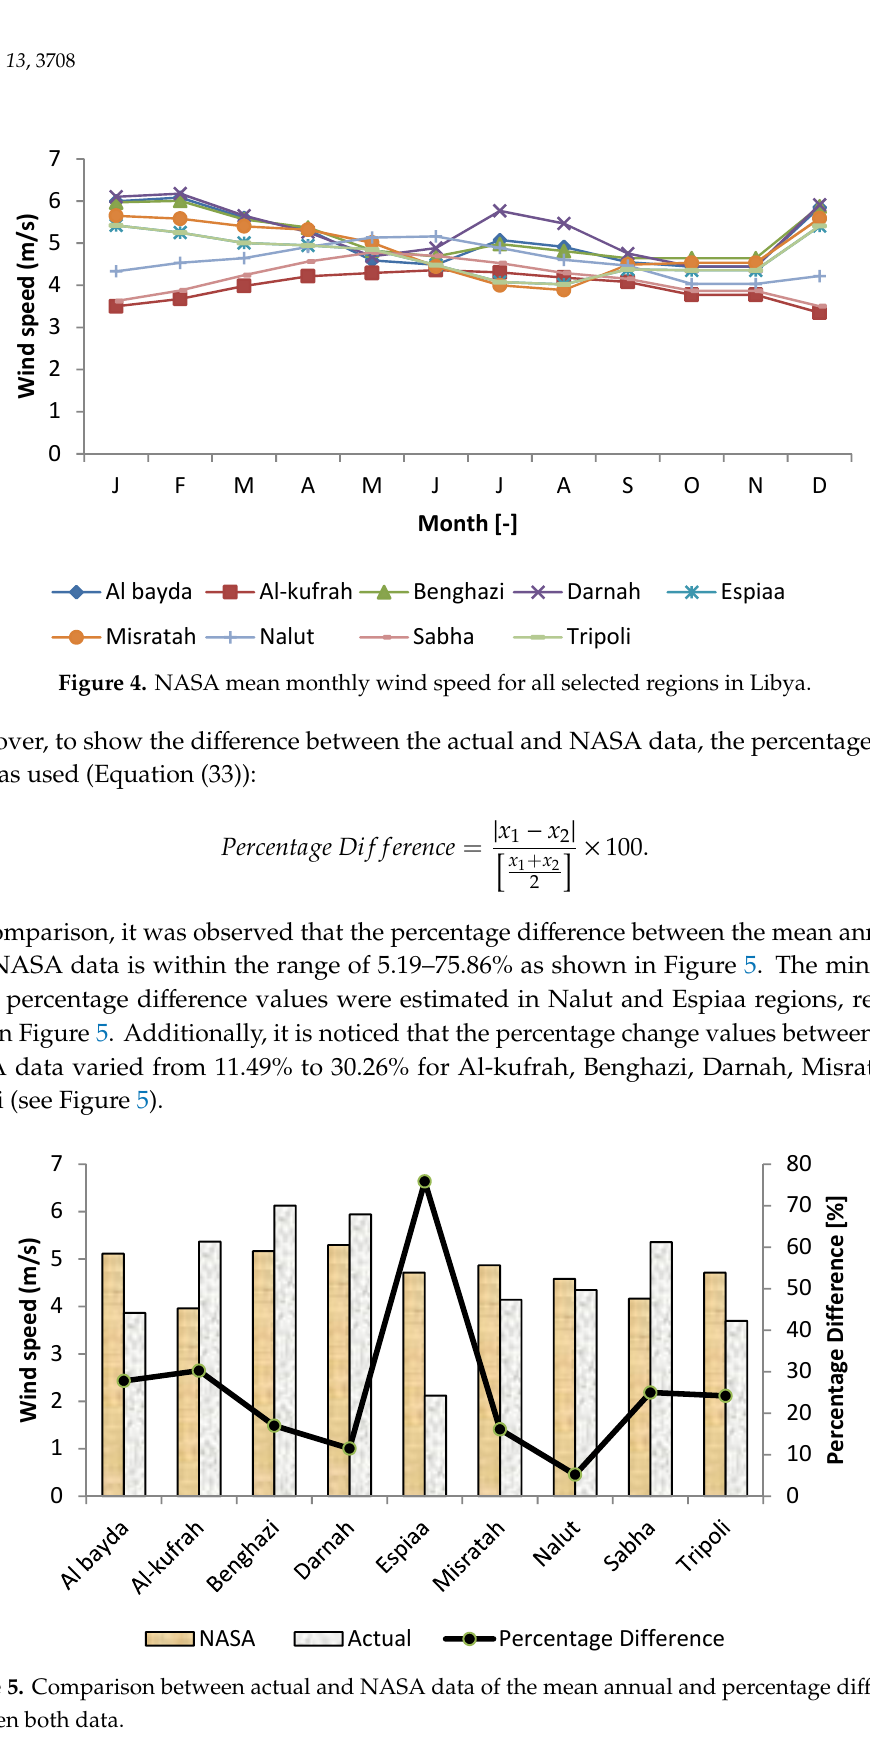
Figure 3. Actual mean monthly wind speed for all selected regions in Libya.